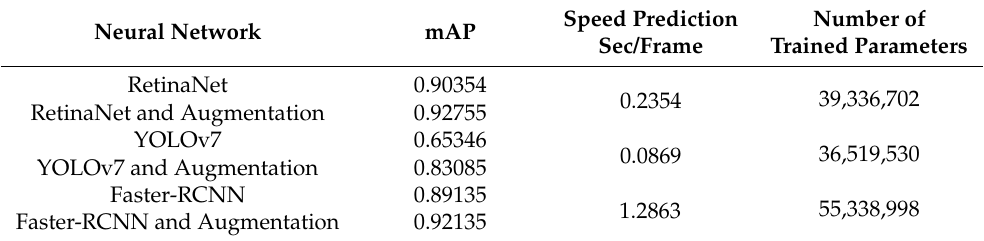
Table 5. Comparison of the different models, including the data augmentation effect. Neural Network